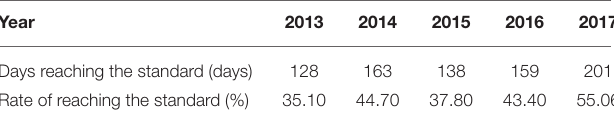
TABLE 9 | Air quality status of reaching the standard in Z City from 2013 to 2017.